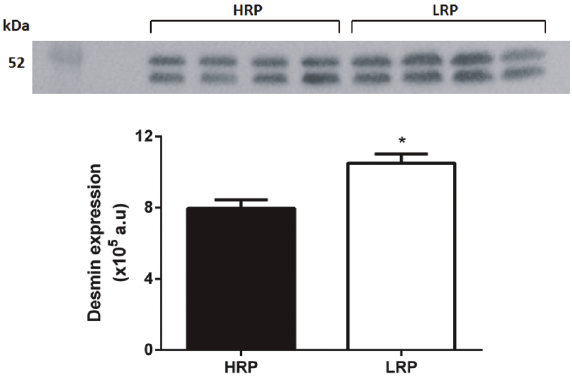
Figure 3. Desmin expression in left ventricle of low running performance (LRP) and high running performance (HRP) rats. Representative immunoblot ( top ) and densitometric analysis ( bottom ) showing changes in desmin protein levels. The membrane was stained with Ponceau S to document equitable protein sample loading. Data are reported means ± SE (n=4); *P o 0.01